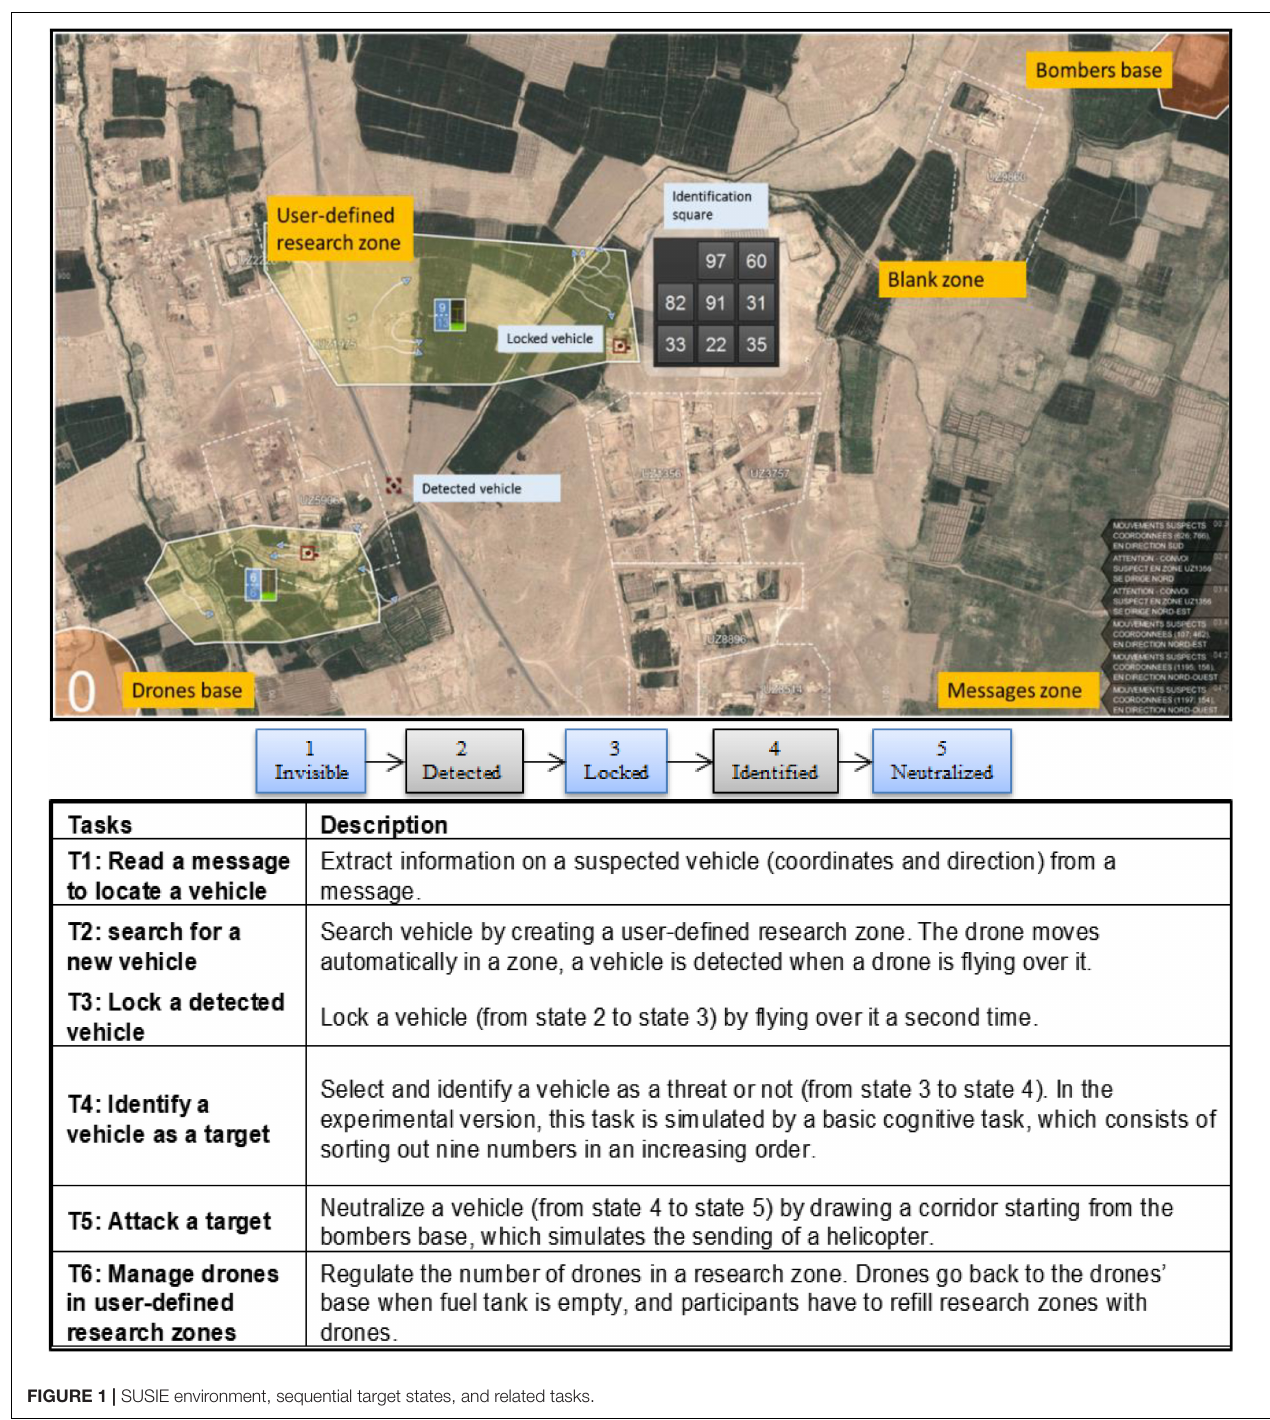
neutralization. The main task is to detect and neutralize the threats (i.e., hostile vehicles) on the map. When a vehicle is generated by the software, it is hidden, i.e., it is present on the map but invisible (it has to be detected by drones sent by the participant). Before it is neutralized, the status of the vehicle changes several times ( Figure 1 , middle image). To